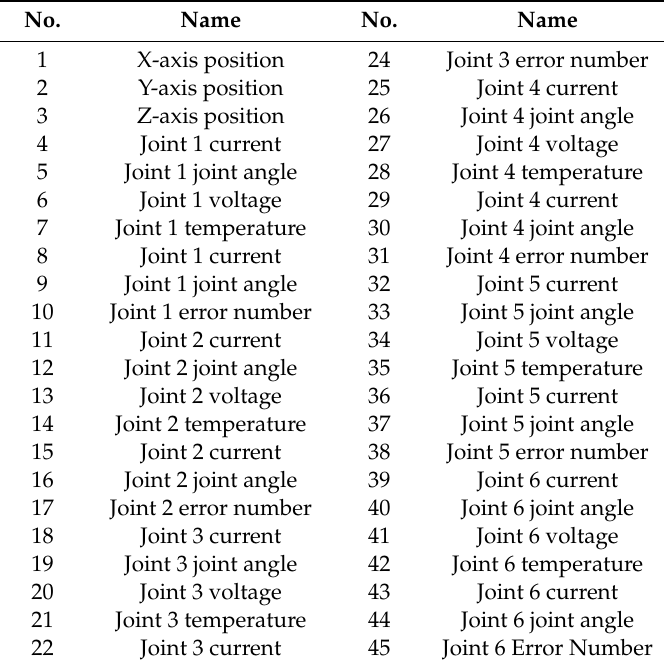
Figure 11. Partially results test of information model mapping to OPC UA server.